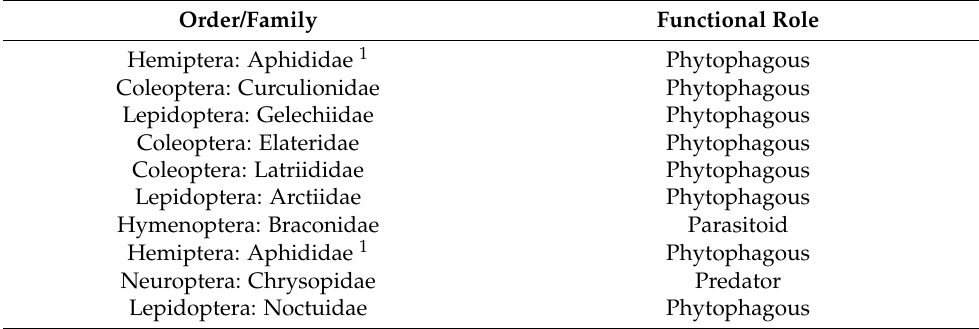
Table 3. Families of insects collected in destructive sampling of quinoa plants. The families are ordered in relation to abundance (from highest to